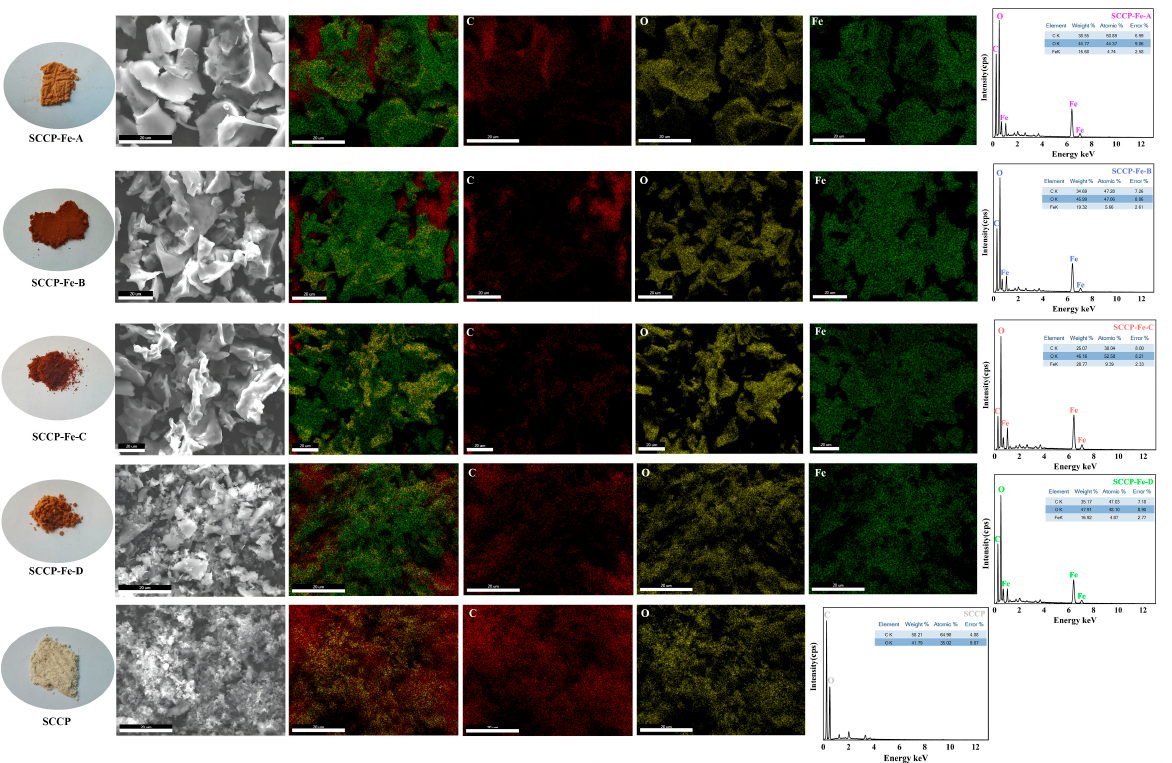
Figure 1. SEM-EDS analysis of four sweet corn cob polysaccharide-iron (III) complexes (physical images, microscopic morphology and scanned images of C, O, and Fe elements).